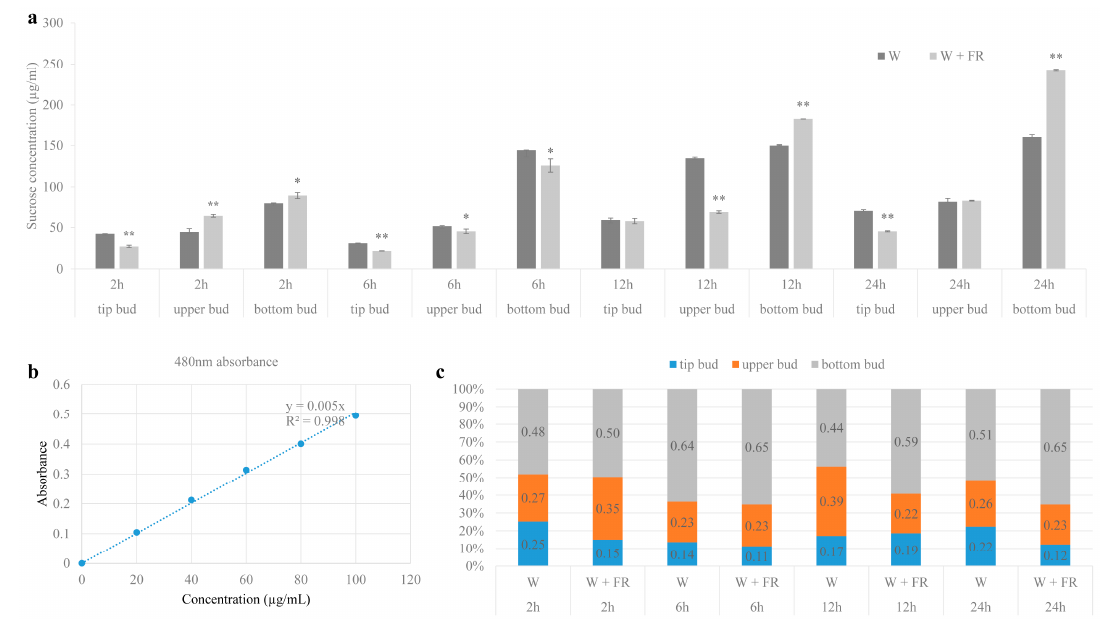
Figure 3. Sucrose accumulation in tip bud, upper bud and bottom bud of plants grown under high R:FR for 41 days (nearly 45 cm height) and then either maintained under high R:FR or provided with low R:FR for 2 h, 6 h, 12 h and 24 h. ( a ) Sucrose concentration; ( b ) Sucrose standardization curves, p -value = 8.075 × 10 − 7 ; ( c ) The distribution proportion of sucrose in tip bud, upper bud and bottom bud. Data are mean ±SE of three biological replicates. Asterisks indicate significant differences between the treatment conditions W and W + FR for each position-bud and each time-point at p < 0.05 (*) and p < 0.01 (**) level.